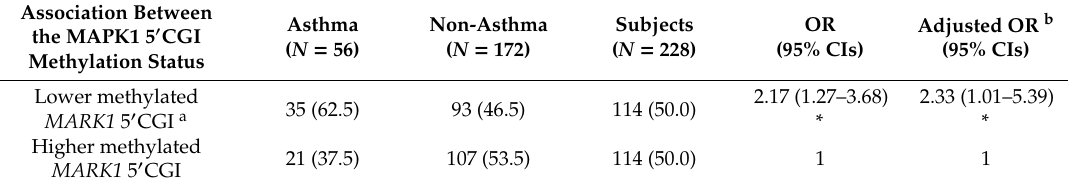
Table 5. The association between the MAPK1 5 (cid:48) CGI methylation status and asthma ( N = 228). Association Between Asthma the MAPK1 5 (cid:48) CGI ( N = 56) Methylation Status